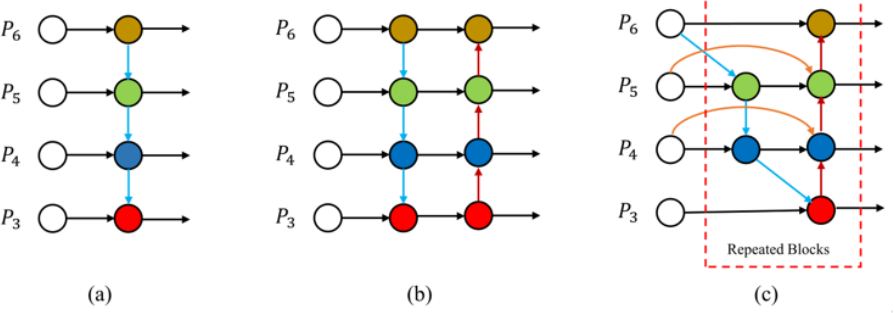
Figure 5. BiFPN network structure diagram, where ( a ) FPN introduces a top-down path to fuse multi-scale features from P3 to P6; ( b ) PANet adds an additional bottom -up path on top of the FPN; multi-scale features from P3 to P6; ( b ) PANet adds an additional bottom-up path on top of the FPN; ( c ) BiFPN removes redundant nodes and adds additional connections on top of PANet. ( c ) BiFPN removes redundant nodes and adds additional connections on top of